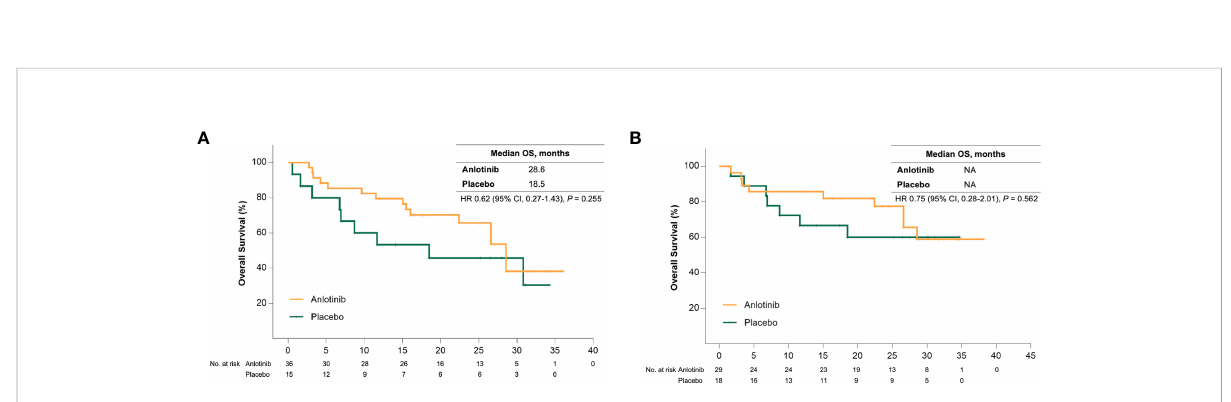
37.9% for older age and bone metastasis subgroups, slightly